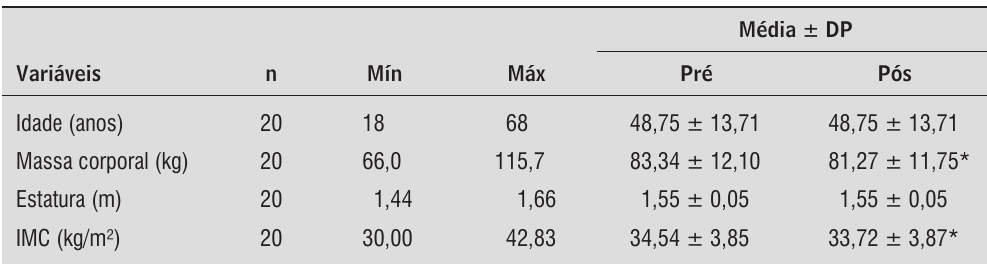
Tabela 1 - Descrição dos valores da média, valor mínimo e máximo, de mulheres obesas sedentárias submetidas ao programa de reabilitação